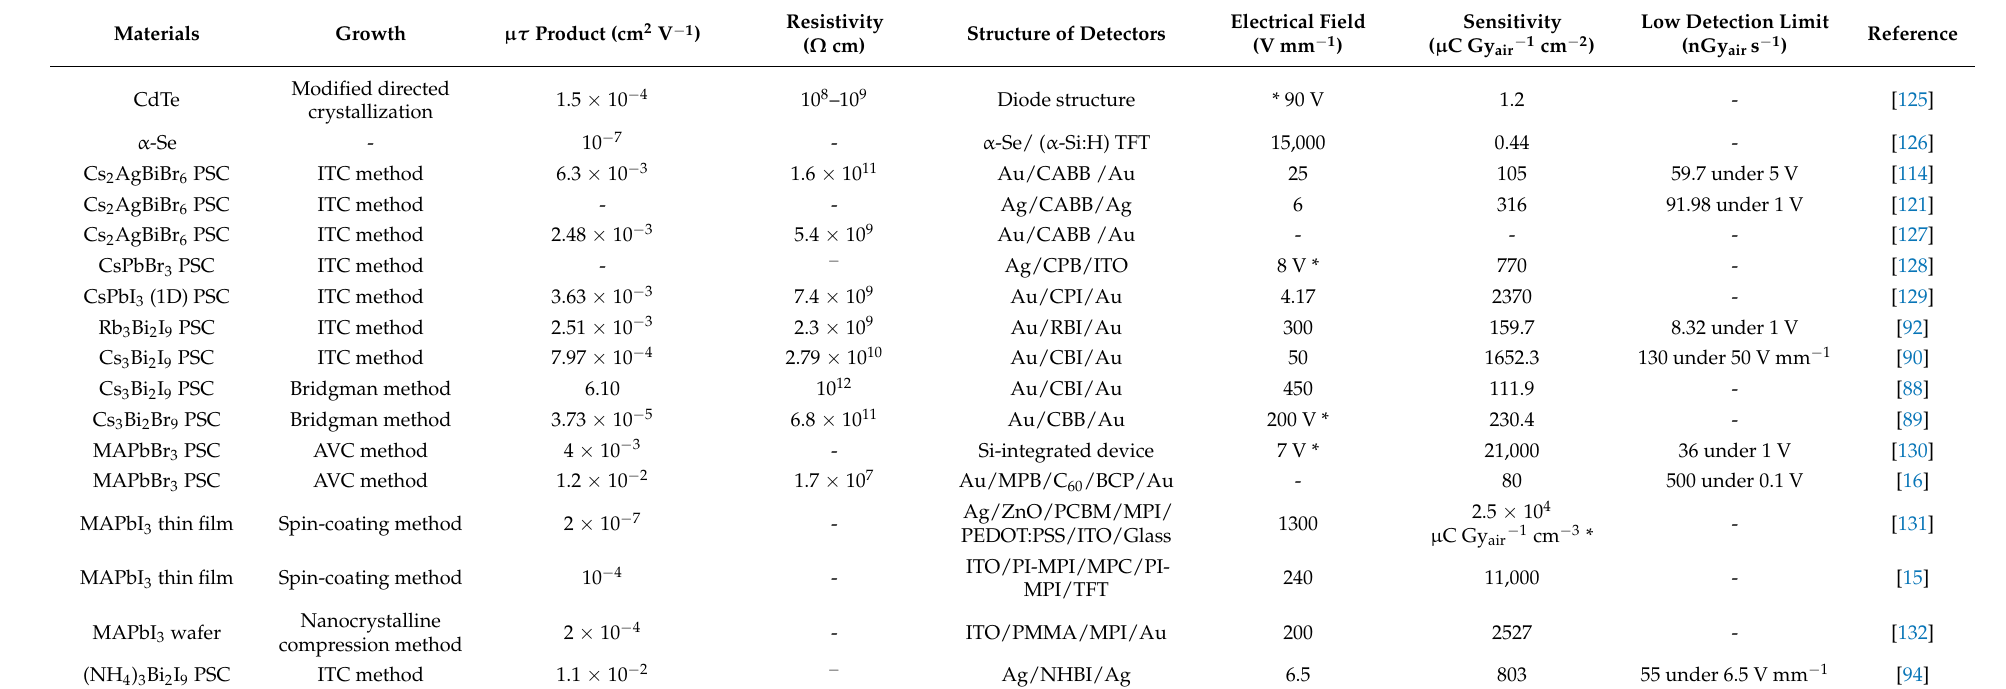
Table 1. Detailed information about the applications of X-ray